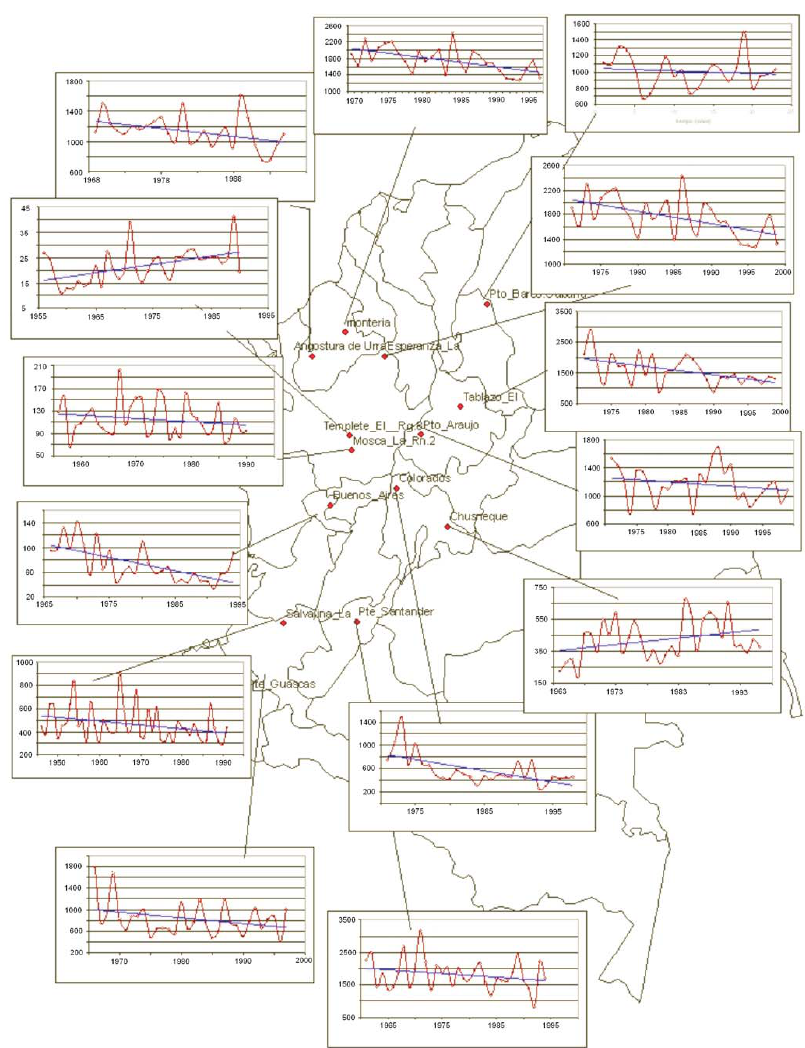
Fig. 3. Spatial distribution of time series of maximum annual river flows ( m 3 s − 1 ) in Colombia. Notice that most time series exhibit statistically significant negative